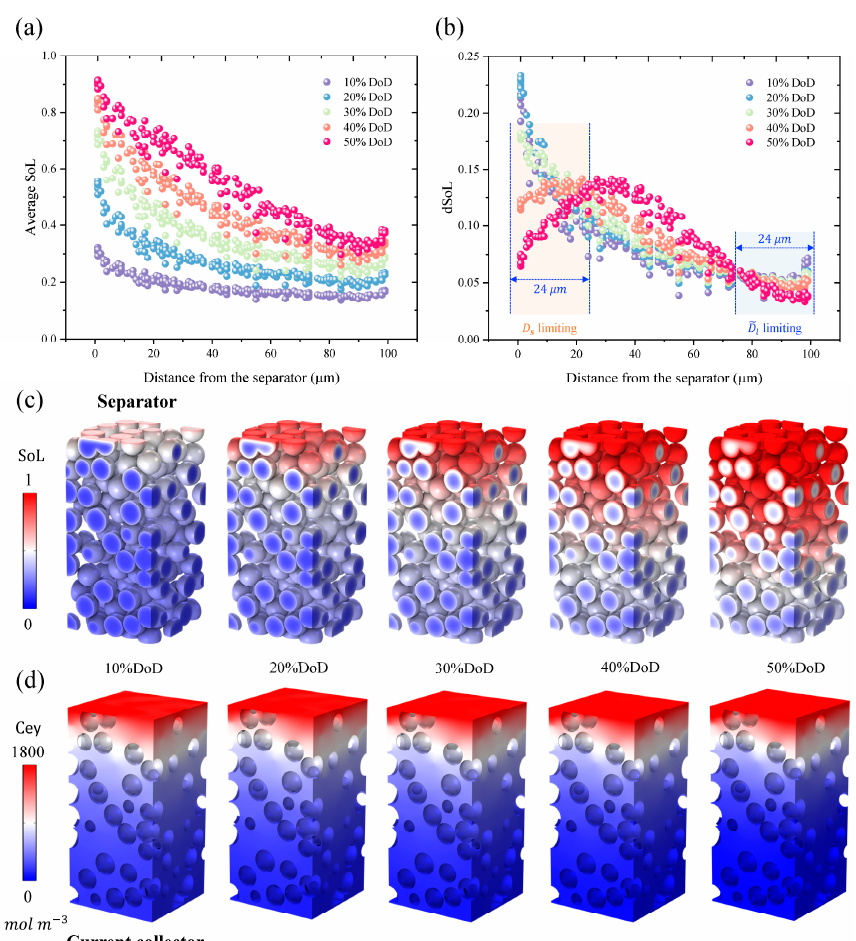
Figure 2. The concentration distribution dynamic evolution of lithium ions in the active materials and electrolyte over time at 5C. ( a ) Average SoL at different DoDs; ( b ) dSoL across the depth of electrode; ( c ) the 3D SoL distribution of particles; and ( d ) the 3D lithium ions concentration profiles in the electrolyte at the corresponding DoD. Note: the maximum DoD achievable for the homogeneous electrode with constant currents discharge at 5C (3.0V cut-o ff ) and 25 °C is 56%.